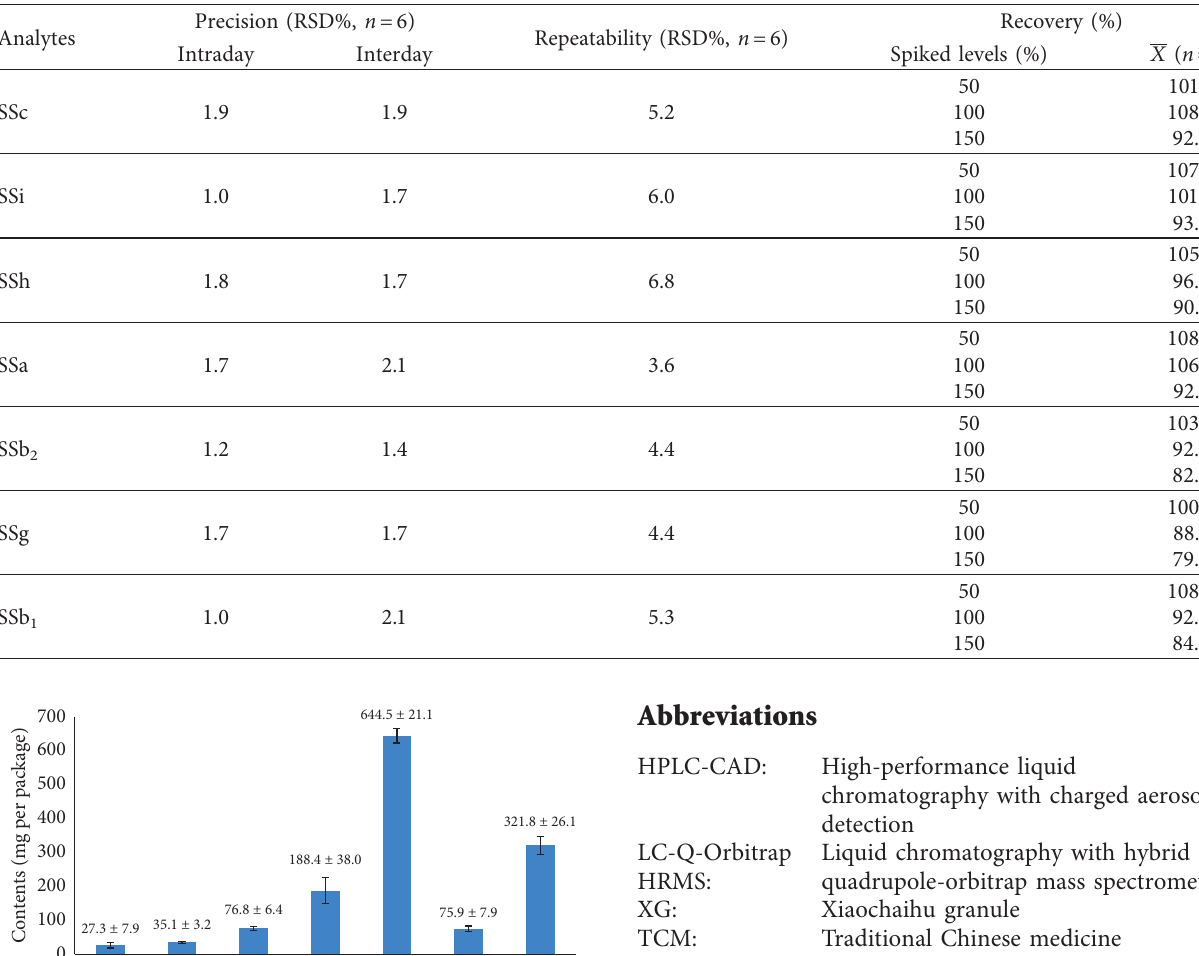
Table 3: Intraday and interday precision, repeatability, and recovery data of 7 saikosaponins. Analytes